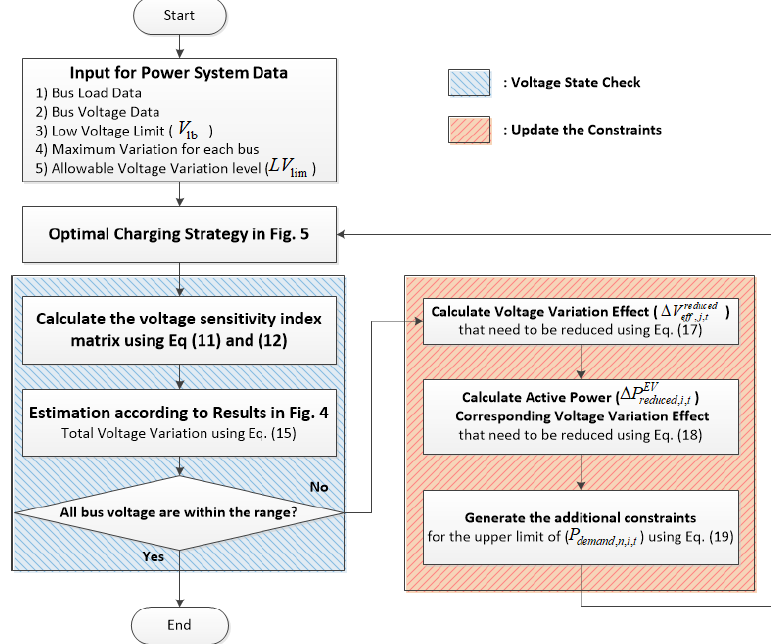
Figure 5. Flow-Chart of Optimal Charging Strategy Considering MPC-based Voltage Stability.